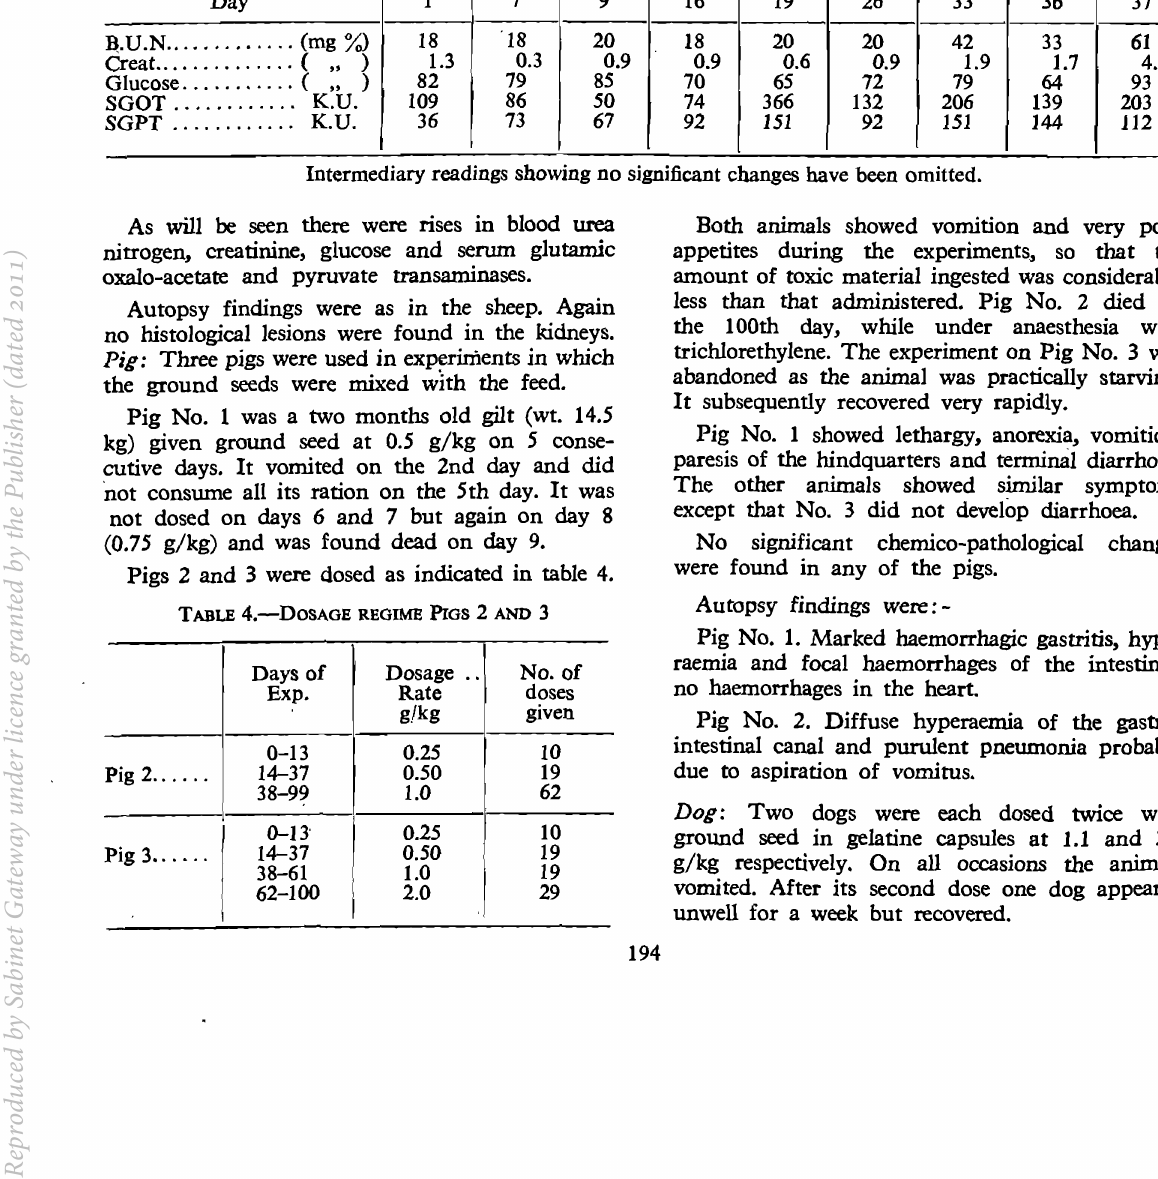
TABLE 3.-CHEMICO-PATHOLOGICAL CHANGES IN BOVINE No.2 DOSED WITH GROUND SEED. Day